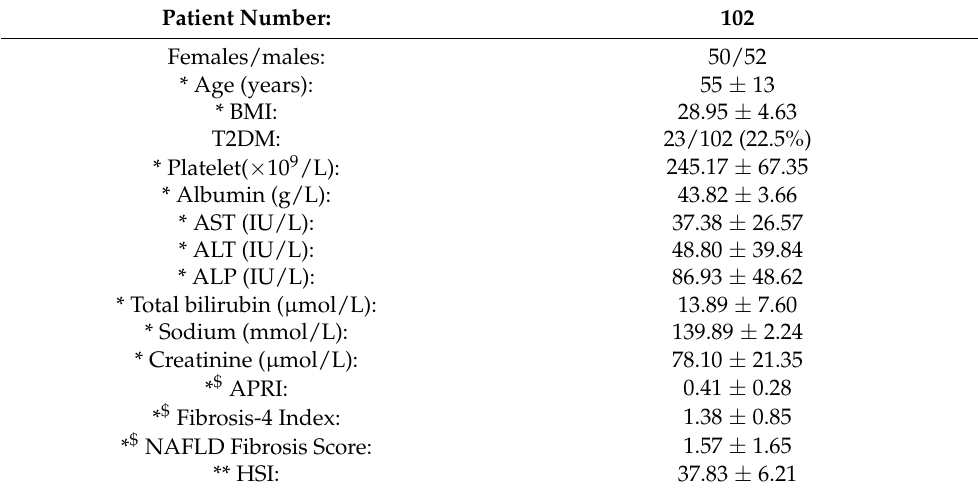
Table 1. Demographic variables and laboratory tests in the NAFLD patient